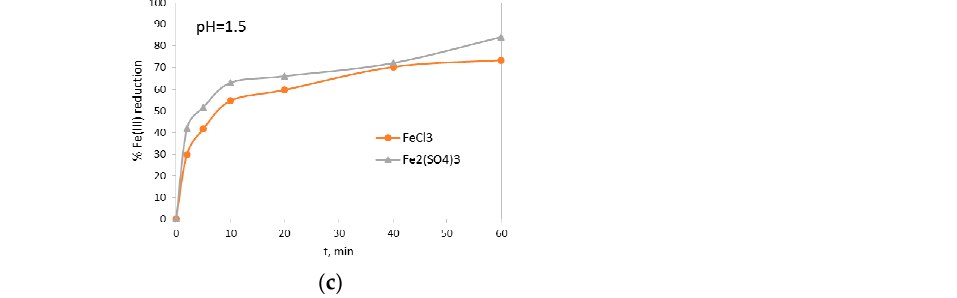
Figure 1. Evolution of Fe(III) reduction with ZVI at ( a ) pH 0.5, ( b ) pH 1.0 and ( c ) pH 1.5 (initial concentrations: Fe(III) 0.22 M; ZVI 0.18 M).